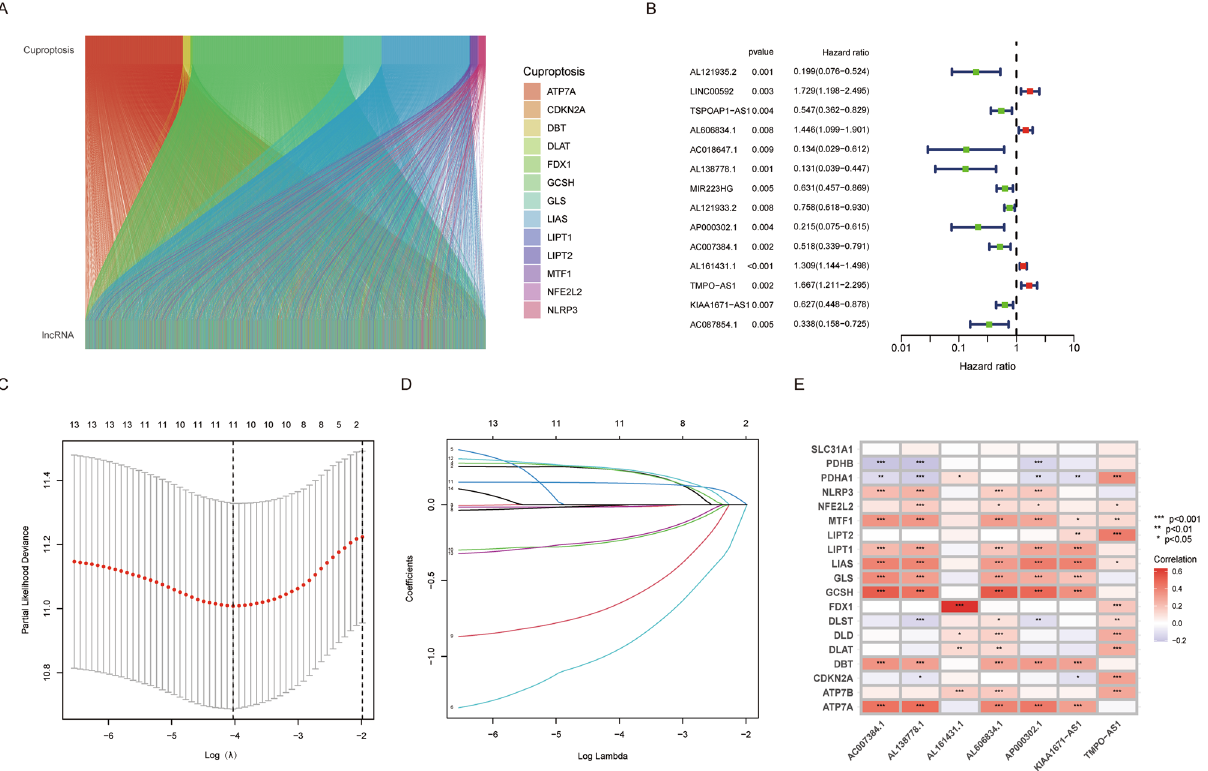
Figure 2. Construction of the Cuproptosis-related LncRNAs Prognostic Signature ( A ) The Sankey diagram shows the connection degree between cuproptosis-related genes and lncRNAs in LUAD patients. ( B ) Forest plots showing the results of the univariate Cox regression analysis between cuproptosis-related lncRNAs and overall survival. (C&D) LASSO regression analysis with a tenfold cross-validation for the prognostic value of the screened lncRNAs. (E) The correlation between lncRNAs screened by multivariate Cox regression and cuproptosis-related (Figure S3A). Our model exhibited a comparable and even better diagnostic performance compared with the existing models. For further validation our risk model in predicting immunotherapy response, we collected the clinical and treatment data from IMvigor210 cohort: http:// resea rch- pub. gene. com/ IMvig or210 CoreB iolog ies and calcu- lated risk score of each patient. Low-risk group exhibited a better prognosis, with p < 0.05 (Figure S3B). We then compared the risk score distribution of each group, including inflamed, excluded and desert. Inflamed subgroup exhibited relatively lowest risk scores, while desert group exhibited highest risk scores, with statically significant differences, which indicated a more abundant immune infiltrations in inflamed subgroup. Also, the from immunotherapy.